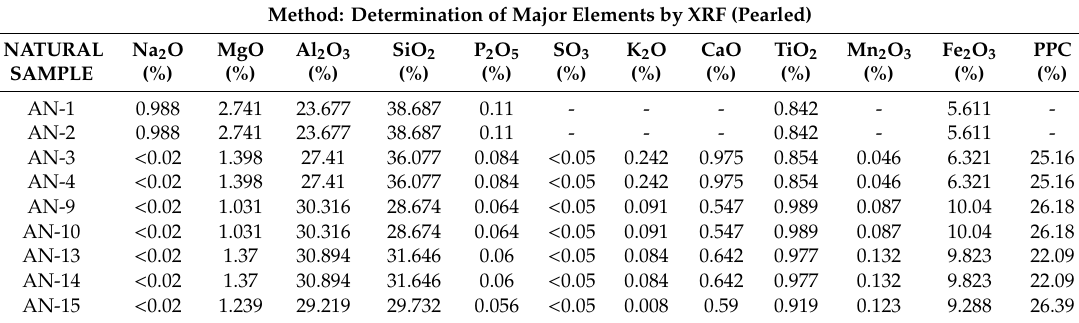
Table 7. Results of the determination of major elements by X-ray fluorescence (WD-XRF).